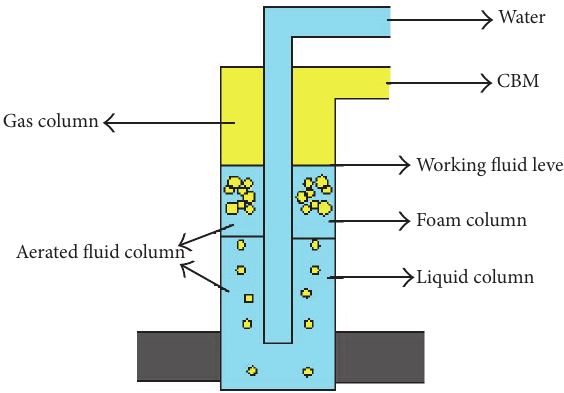
Figure 1: The annulus fluid distribution in the CBM